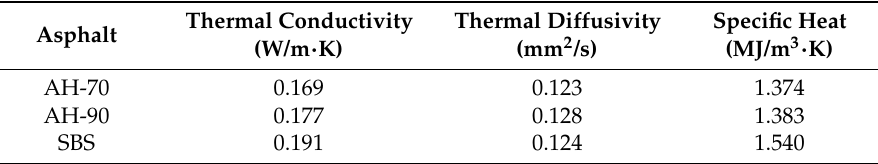
Table 3. Thermal properties of different types of asphalt binders.